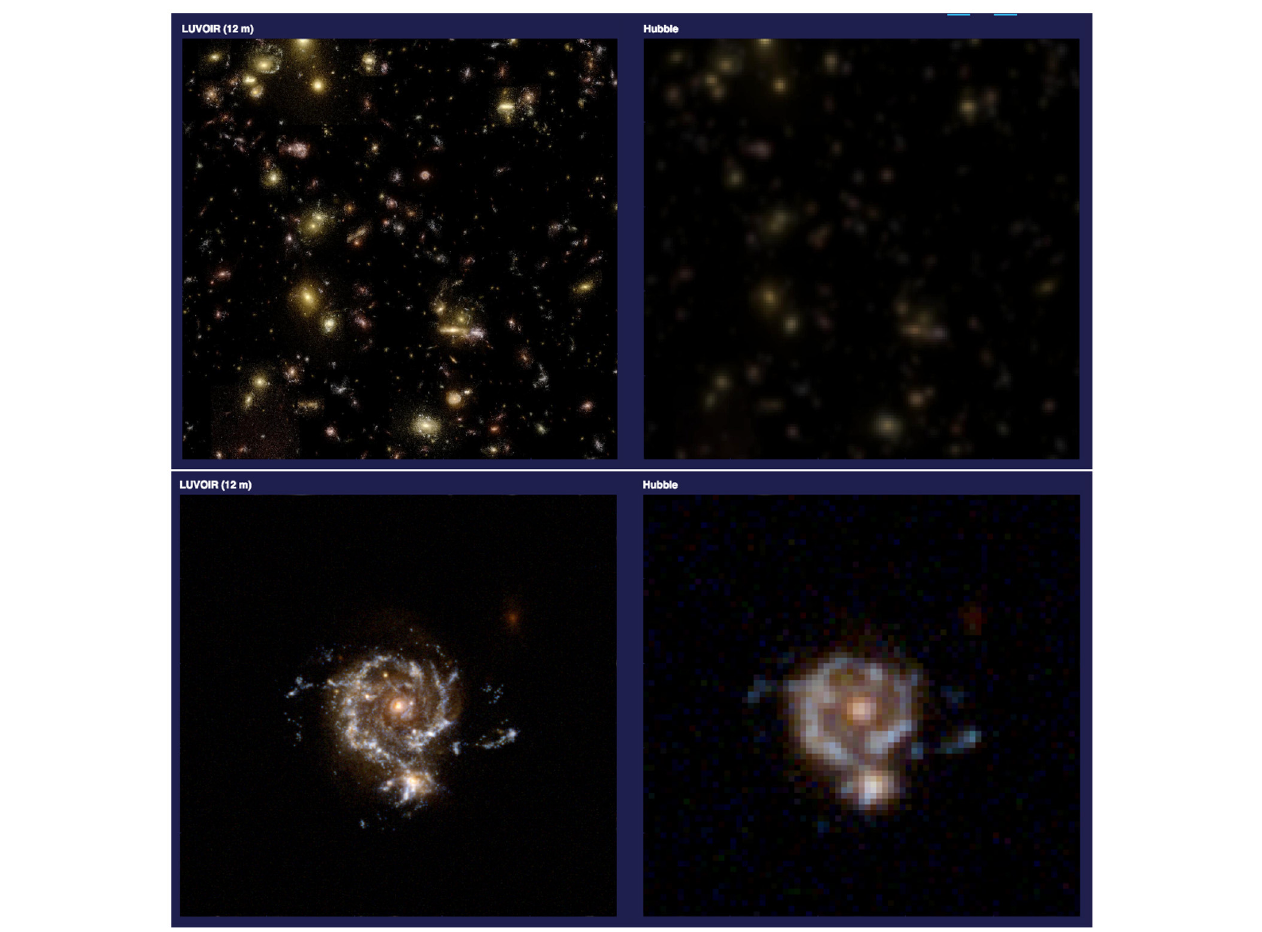
FIGURE 1 | Comparison between expected performance of LUVOIR, an optical space based telescope of 12m aperture (Left) , and HST (Right) , for a deep field (Top) and for the morphology of a galaxy at redshift 2 (Bottom) . Credit: LUVOIR, image comparison page, at http://luvoir.stsci.edu. ≈